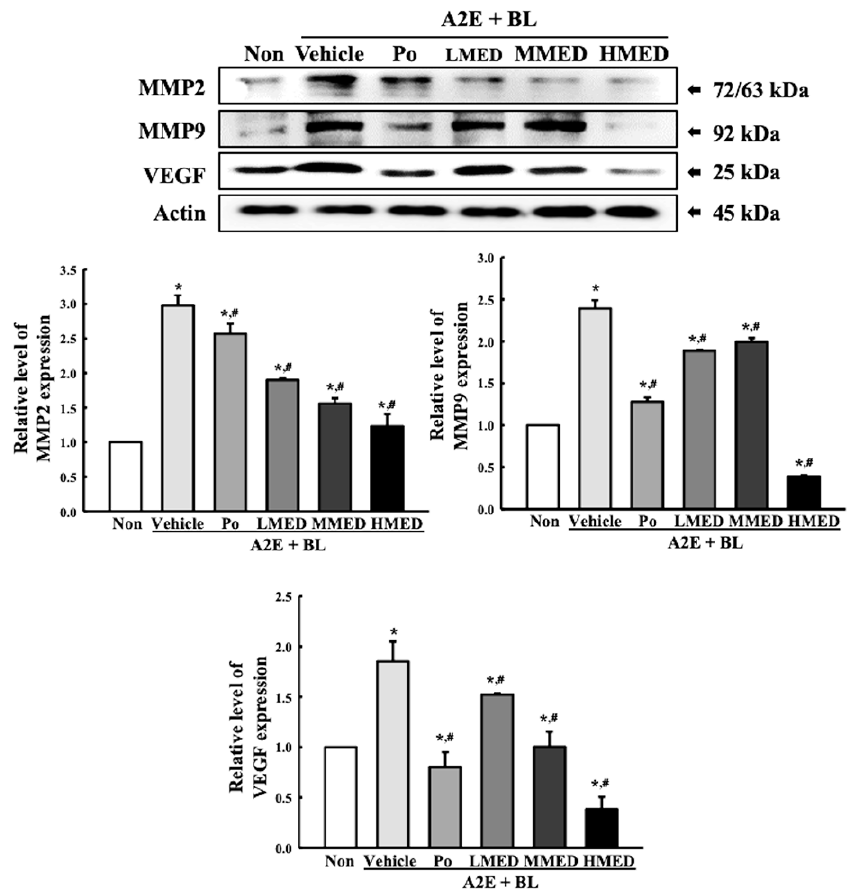
Figure 7. Expression of angiogenic proteins in MED + A2E + BL treated ARPE19 cells. After treatment with MED for 24 h, the expression levels of angiogenic proteins, including MMP2, MMP9, VEGF and actin were measured in total cell lysates using Western blot analysis. The total proteins homogenates were prepared from two to three samples per group, and Western blot analyses for each sample was analyzed in duplicate. All values in results are represented as the means ± standard deviation (SD). * indicated statically significance compared to the Non treated group, while # indicated statically significance compared to the Vehicle + A2E + BL treated group. Abbreviations: MMP, Matrix metalloproteinase; VEGF, Vascular endothelial growth factor; MED, methanol extracts of Dipterocarpus tuberculatus Roxb.; A2E: N-retinylidene-N-retinylethanolamine; BL, Blue light.